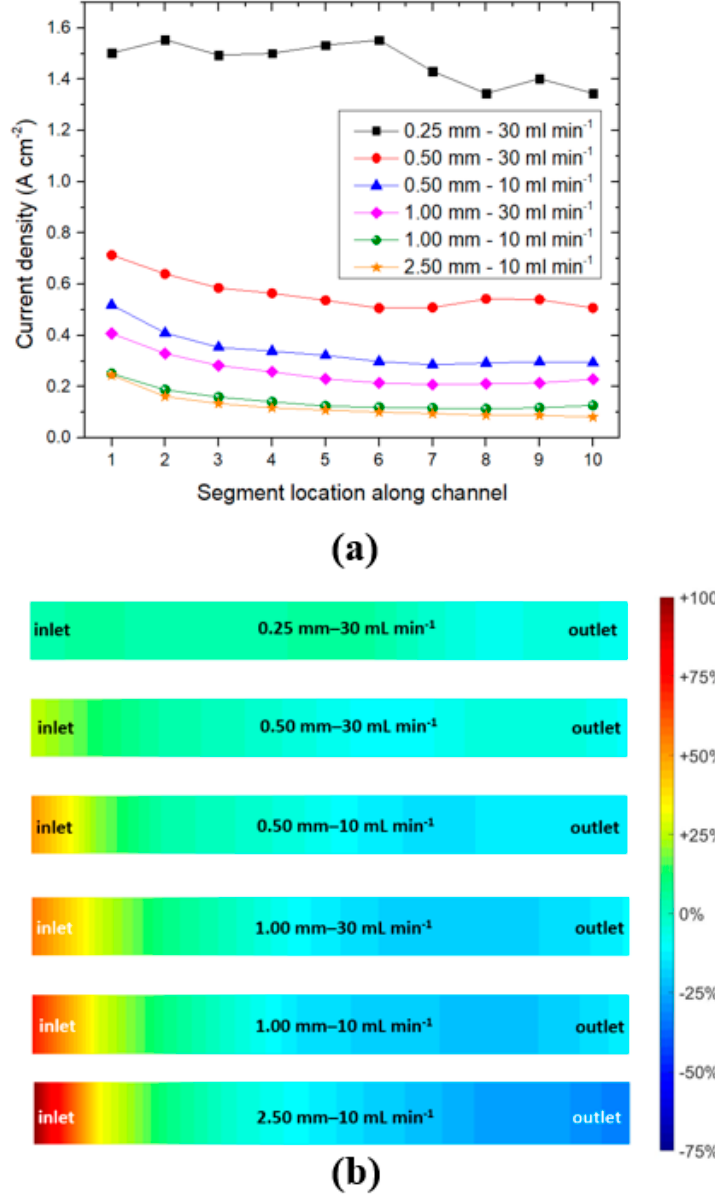
Figure 5. Measured local current ( a ) and ( b ) normalized current distribution comparisons at 50% SOC, 30 mL/min, 0.2 V hold.